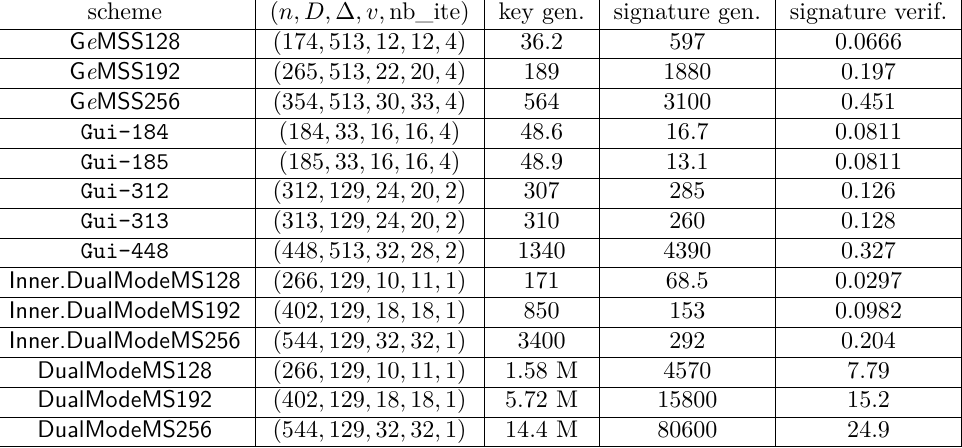
Table 32: Number of mega cycles for each cryptographic operation with MQsoft . We use a Skylake processor (DesktopS). scheme ( n, D, ∆ , v, nb_ite) key gen. signature gen. signature